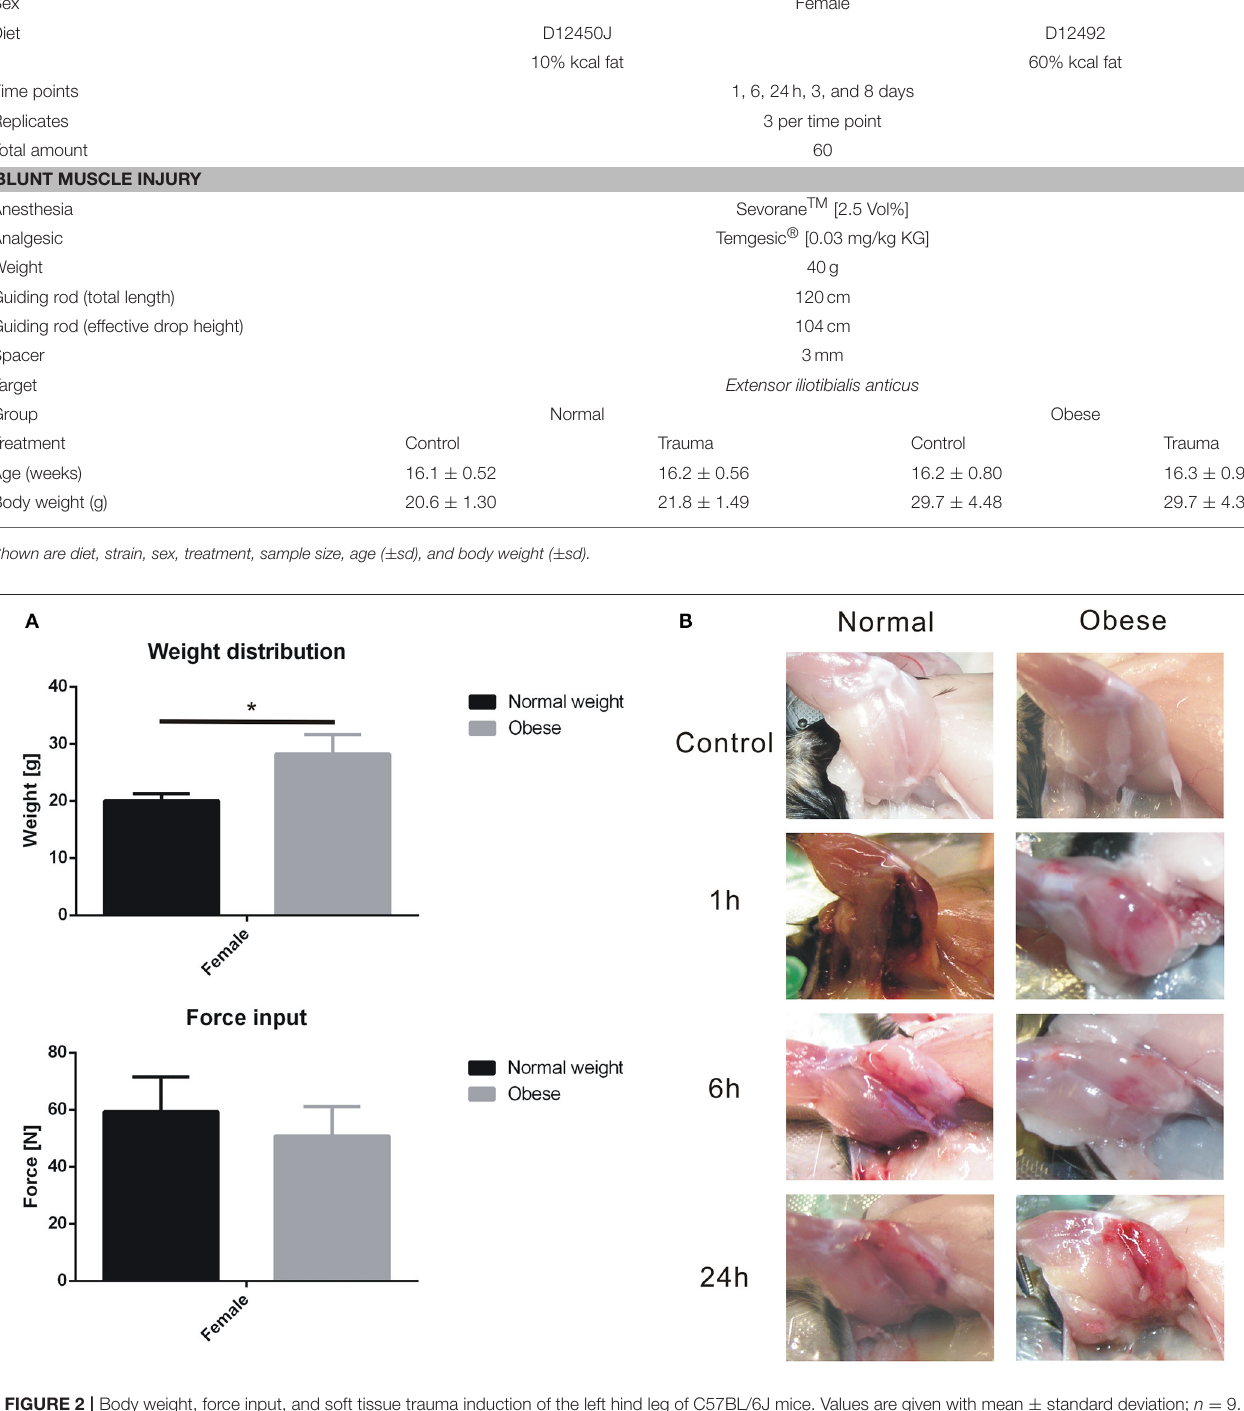
Frontiers in Physiology |